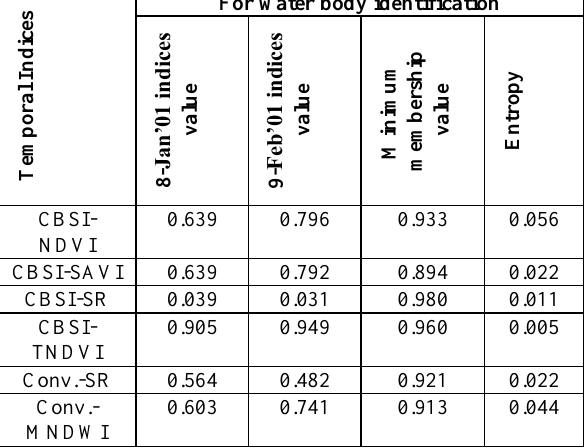
Figure 2. Different classified output for liquefaction